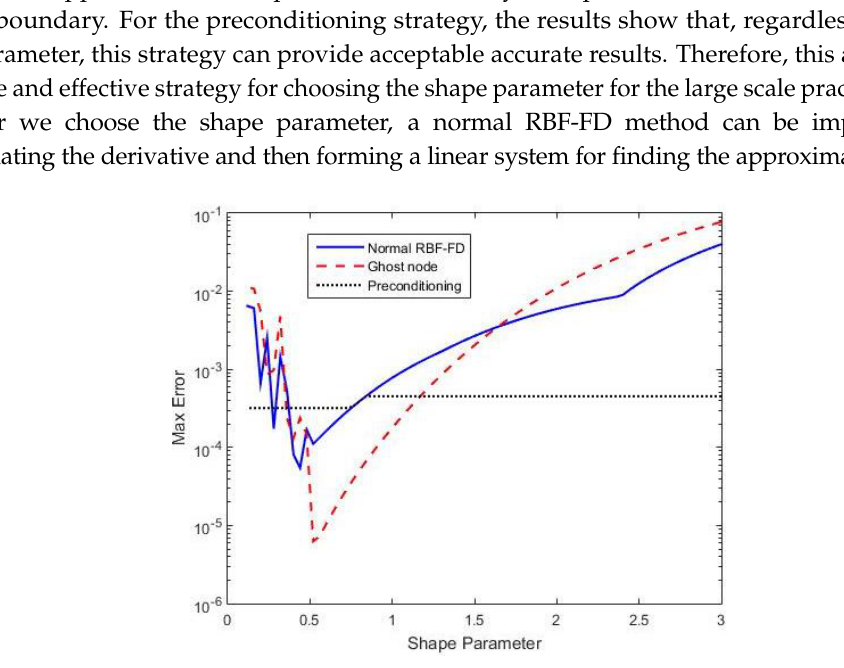
Figure 4. The graph shows the comparing of max error among the RBF-FD method with ghost nodes, the RBF-FD method with preconditioning, and the normal RBF-FD method. In the case of the RBF-FD method with preconditioning, we plot the max error against the initial shape